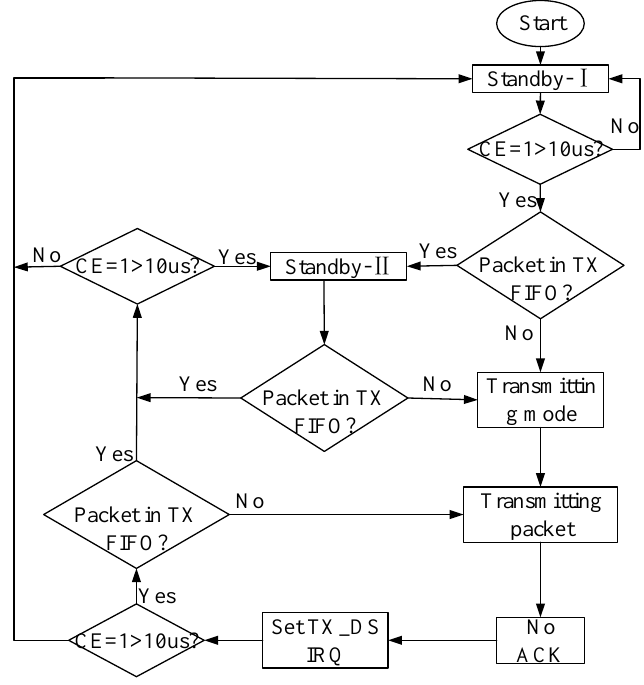
Figure 8. The nRF24L01 data transmission